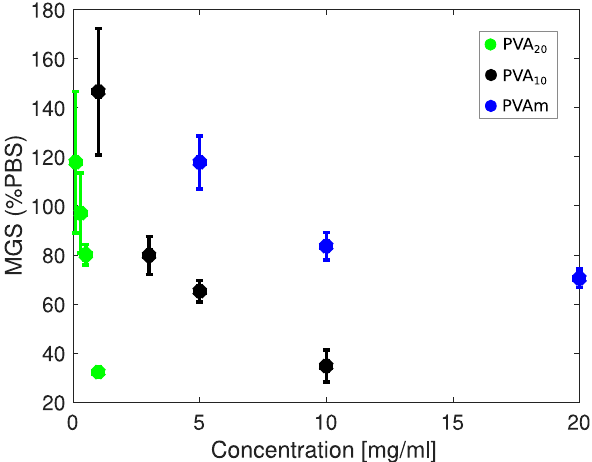
Fig. 8 Experimental IRI activity of PVA 20 , PVA 10 and PVAm. Mean grain size (MGS) of the ice crystals measured via splat-assay in the presence of different polymers, as a function of their concentration. The error bars represent the standard deviation for each sets of measurements. The results have been normalised relative to a PBS control. Our MD simulations are consistent with experimental results which show that PVA 20 is the most IRI active, with PVA 10 and PVAm showing far less activity even at higher concentrations. Note that a 30% MGS can be obtained for PVA 20 at a concentration of just 1 mg/ml, while a tenfold concentration increase would be required for PVA 10 to display a similar activity. The molecular weight of PVAm (DP = 580) is 25000 g/mol.